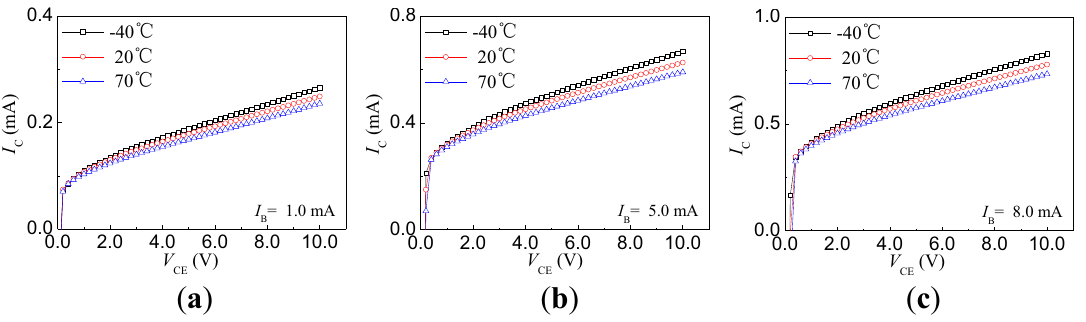
Figure 7. Temperature characteristics of the magnetic sensitivity transistor with nc-Si:H/c-Si heterojunction: ( a ) I B = 1.0 mA; ( b ) I B = 5.0 mA; ( c ) I B = 8.0